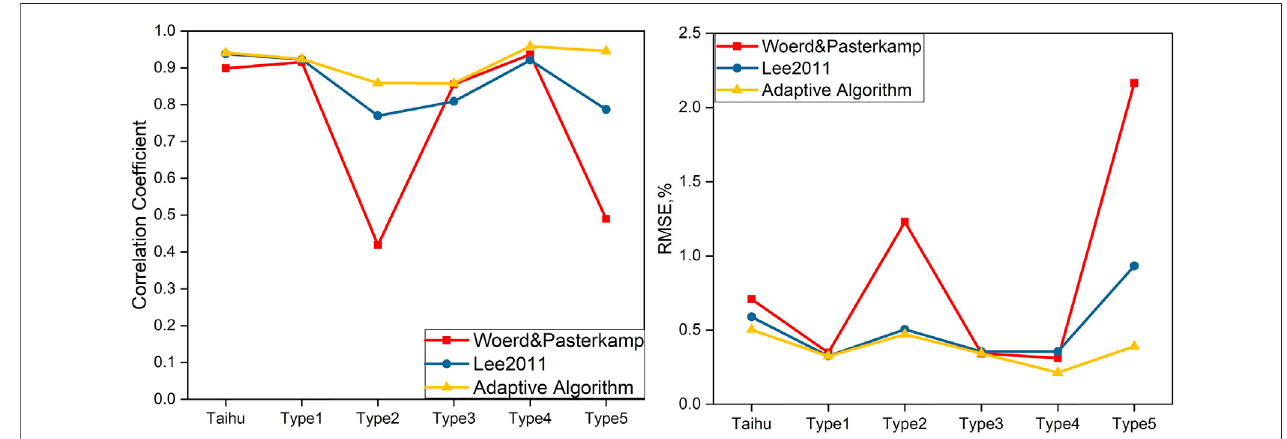
FIGURE 11 | RMSE values and correlation coef fi cients of measurements and simulations conducted at the Green Band.